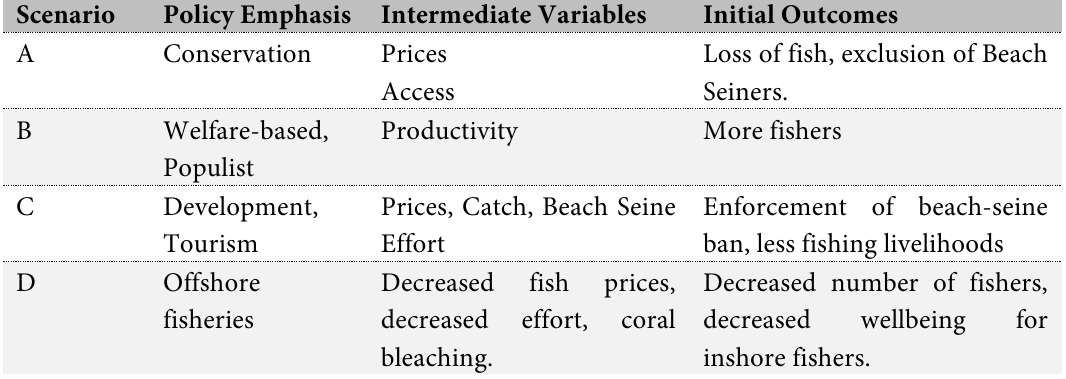
Table S4. Structuring ‘forces’ of